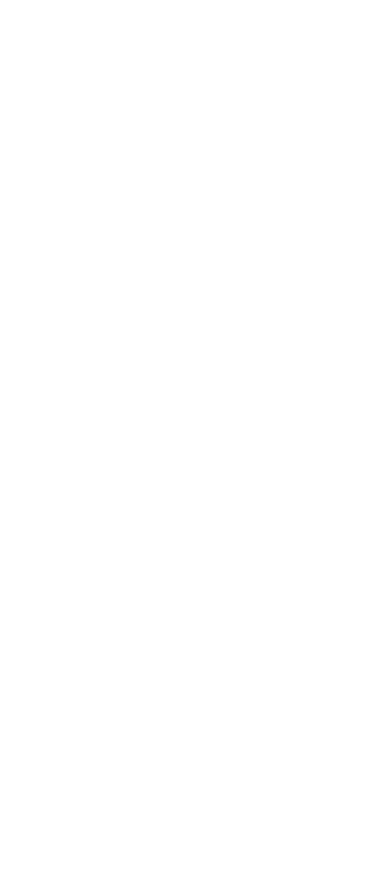
FIGURE 1 | Genetics of the exlA strains and the synthesis of ExlA. (A) Phylogenetic tree of Pseudomonas aeruginosa strains created by genome comparison [derived from Kos et al. (2015)], showing the two genetic outlier clusters, PA7 and PA39. The PA7 strains and most PA39 strains possess the exlA gene, as opposed to classical strains. The lower panel shows the entire tree with uninterrupted lines. (B) Transcription of the exlB – exlA operon is enhanced by Vfr and negatively regulated by the ErfA transcription factor. The 172-kDa ExlA protein consists of a secretion signal peptide (SP), a two-partner secretion (TPS) domain that interacts with ExlB, fi lamentous hemagglutinin adhesin (FHA)-like repeats, and a C-terminal (C-ter) domain. (C) Both ExlA and ExlB are secreted into the periplasm via the sec pathway. ExlB is predicted to insert into the outer membrane. ExlA is exported into the extracellular milieu through the pore formed by ExlB. When intracellular concentrations of c-di-GMP are high, ExlA translocation stalls at midway with part of the toxin pointing outside. It is hypothesized that secretion resumes when ExlA interacts with a host receptor. (C) Created with